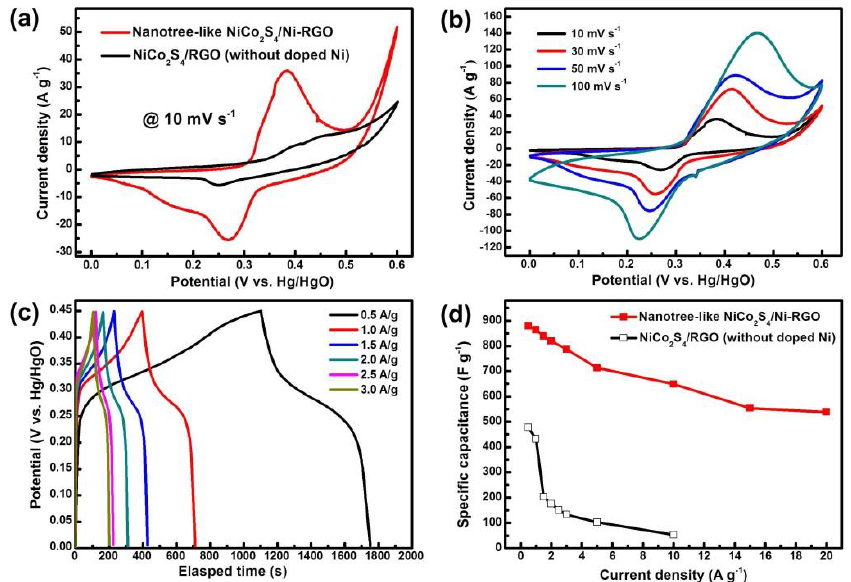
Figure 5. Electrochemical characterization of the NiCo 2 S 4 /Ni-rGO nanocomposites: ( a ) Cyclic voltammetric curves with / without Ni-doping; ( b ) CV curves at various scan rates; ( c ) Galvanostatic voltammetric curves with/without Ni-doping; ( b ) CV curves at various scan rates; ( c ) Galvanostatic charge-discharge curves at di ff erent current densities; and ( d ) specific capacitance vs. current charge-discharge curves at different current densities; and ( d ) specific capacitance vs. current density density plots. plots.